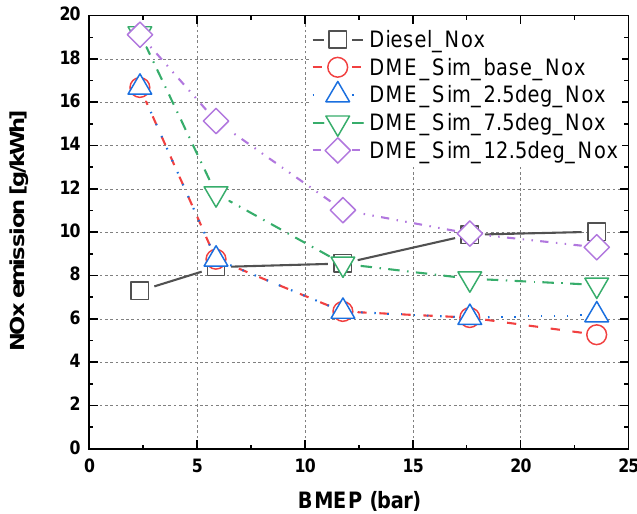
Figure 6. Characteristics of NOx emission versus start of injection timing for marine diesel fuel and DME fuel.